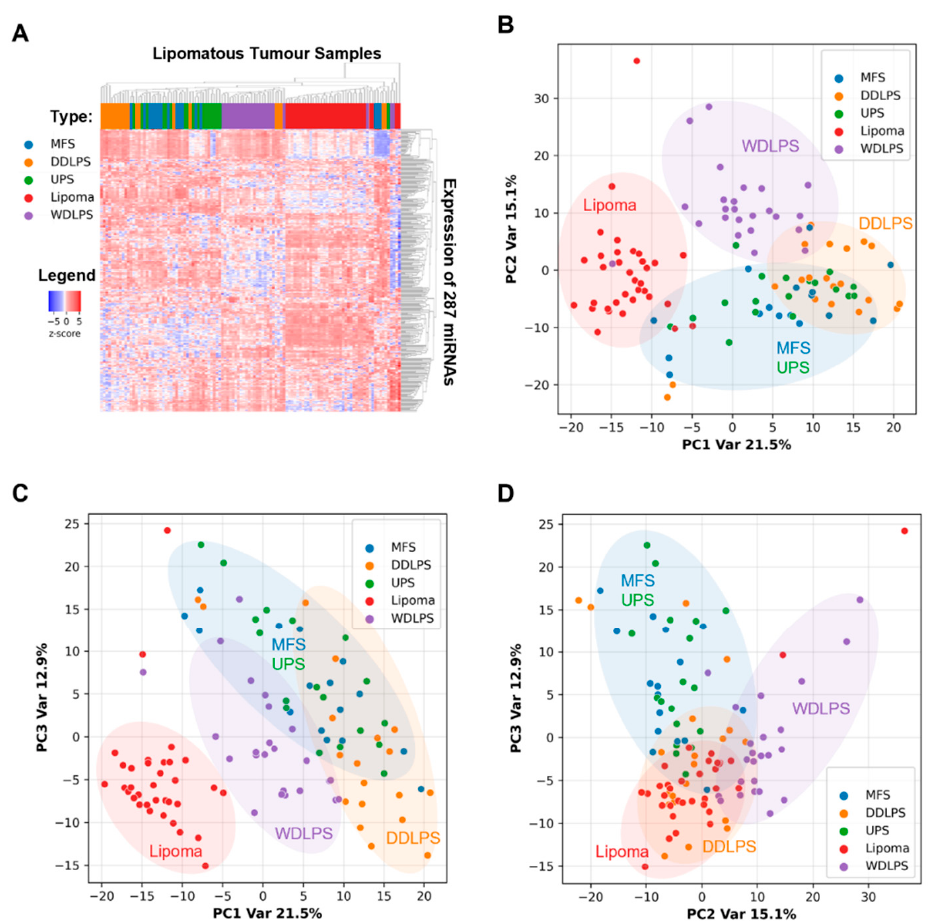
Figure 3. Biologically distinct soft tissue tumors can be differentiated by microRNA expression profiles. ( A ) Heatmap showing hierarchical clustering of benign (lipoma) and malignant (WDLPS, DDLPS, MFS, UPS) soft tissue tumor FFPE samples using their microRNA expression profiles measured by qPCR. ( B – D ) Results of principal component analysis (PCA) on miRNA expression profiles of soft tissue tumor FFPE samples shown in graphs plotting ( B ) principal component 2 (PC2) against principal component 1 (PC1), ( C ) principal component 3 (PC3) against PC1, and ( D ) PC3 against PC2.